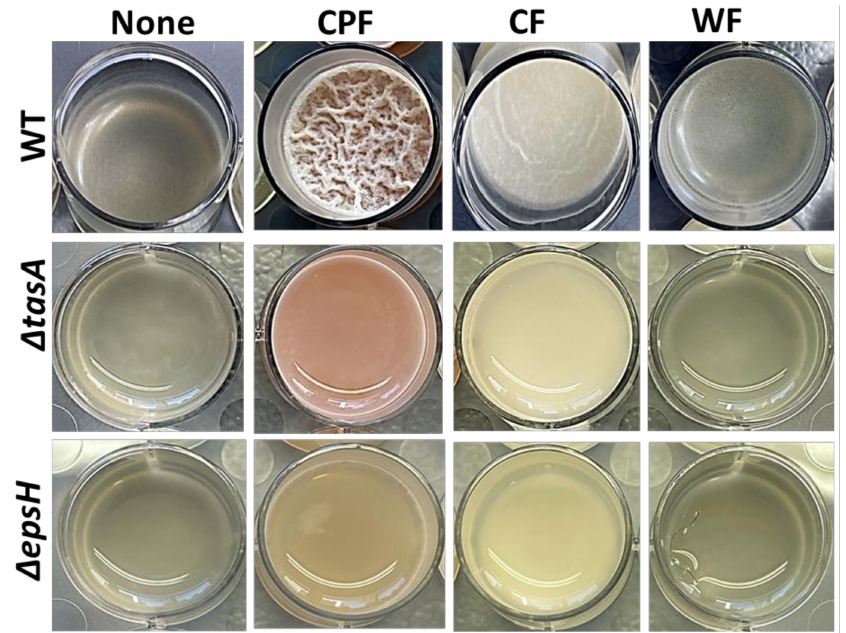
Figure 2. Differential induction of biofilm formation by plant-based prebiotic substances. The 3% ( w/v ) of each prebiotic substance were added to LB and the cells of B. subtilis (WT, ∆ epsH , and ∆ tasA ) were grown in the medium for 72 h prior to capture by iPhone camera. This image is representative of three biological